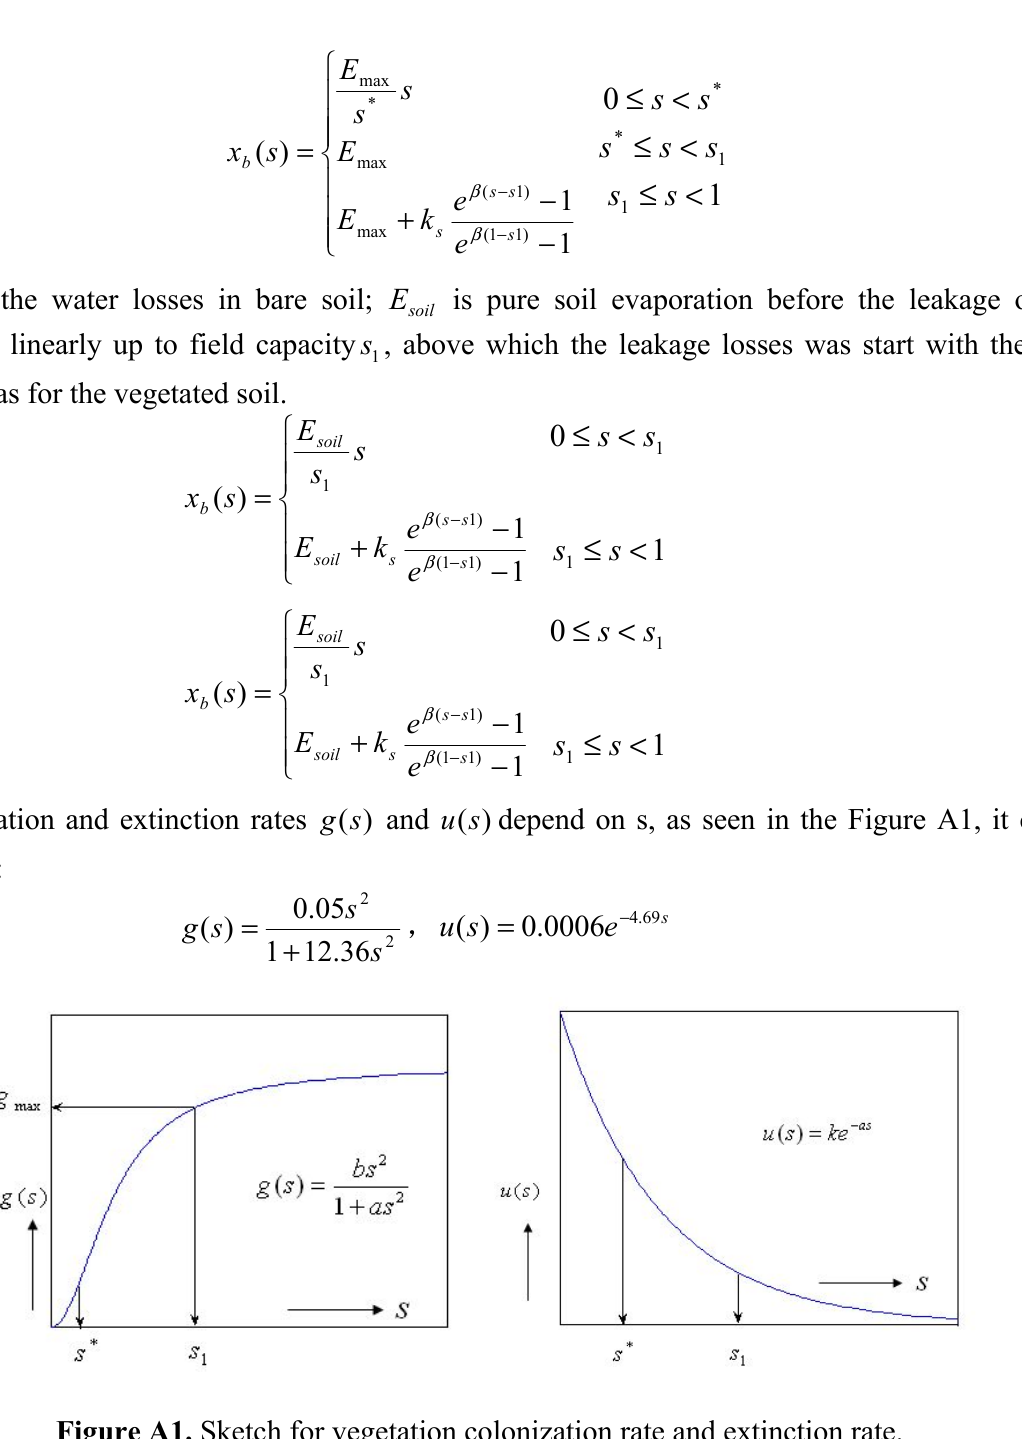
Figure A1. Sketch for vegetation colonization rate and extinction